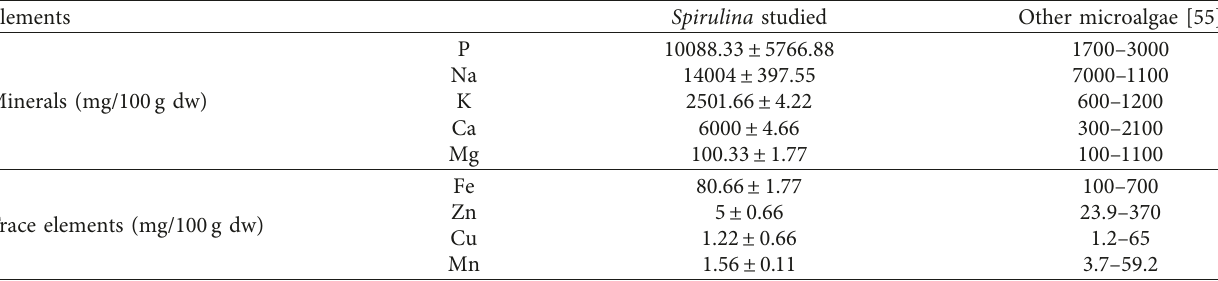
Table 2: Mineral composition of Spirulina (Morocco) (mg/100g